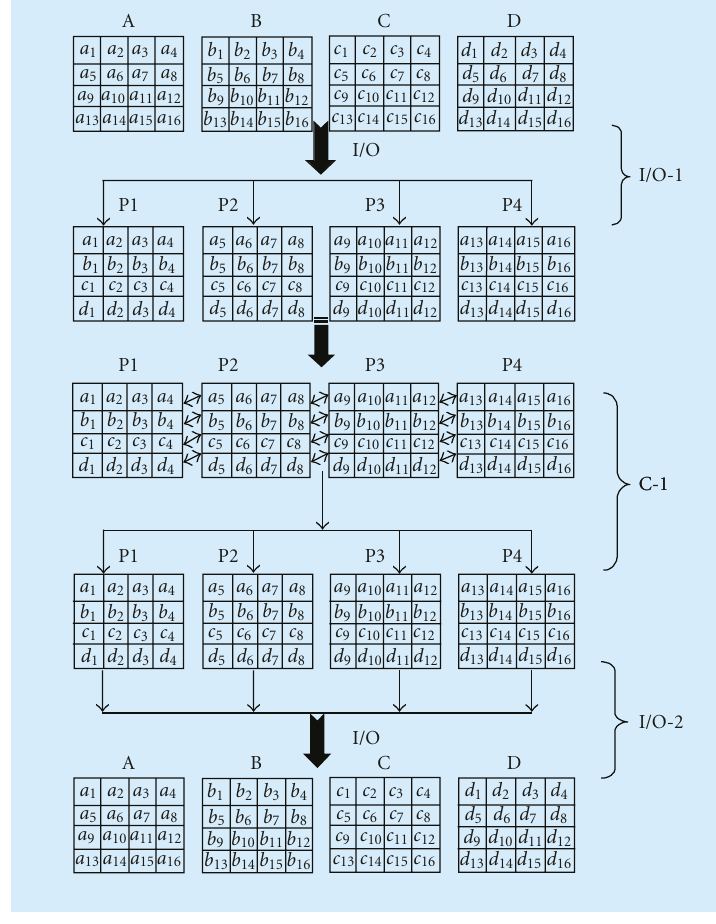
Figure 7: Parallel scheme: 4 frames per GOF and 4 processors (P: processor, C: communication, I/O: parallel input/output).